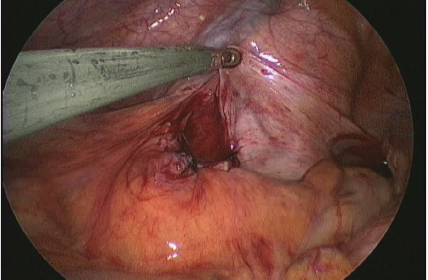
Figure 4: Intraoperative finding 3: theintersigmoid fossawas closed with interrupted